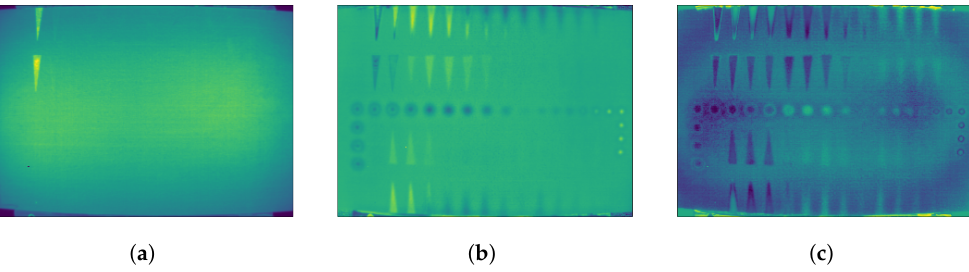
Figure 6. ( a ) Raw data at Frame 5; ( b ) fifth component of PCT data; and ( c ) fifth component of RPCT